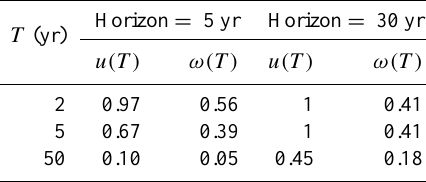
Table 4. Values of u(T ) and ω(T ) .